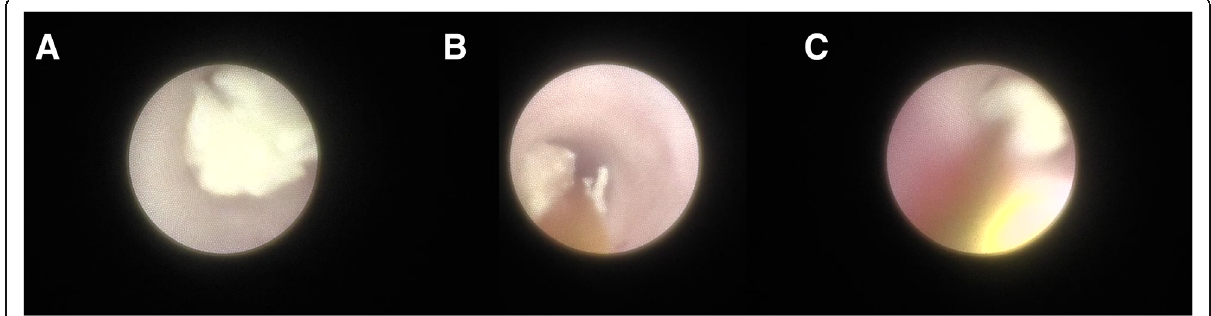
Fig. 3 Endoscopic view during sialolithotomy. a Stones in the duct are observed. b Basket is approaching to engage stones. c Stones are engaging in the basket and removed from the